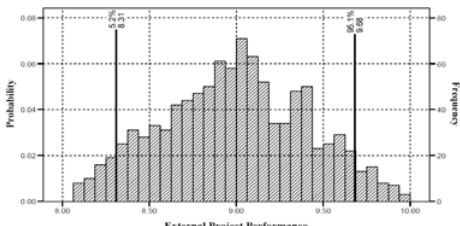
Figure 3 Probability density distribution for customer satisfaction, 1,000 simulated cases scenario